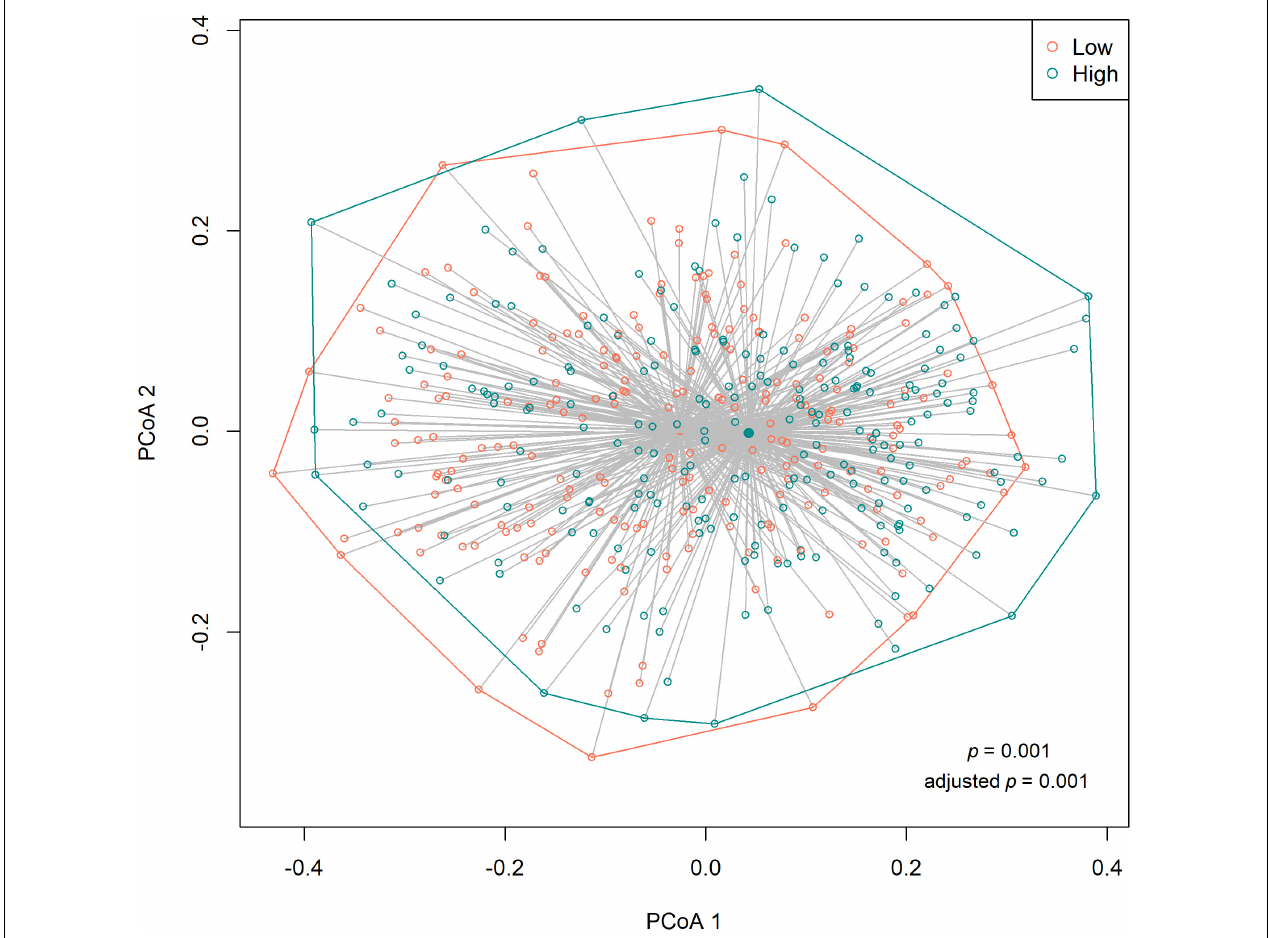
FIGURE 2 | Principal coordinates analysis (PCoA) based on the Bray–Curtis distances (beta diversity) according to low ( n = 227) and high ( n = 226) sweet treat consumption. Results based on PERMANOVA. Adjusted p -value from a model adjusted for sex, age, waist–height ratio, and maternal socioeconomic